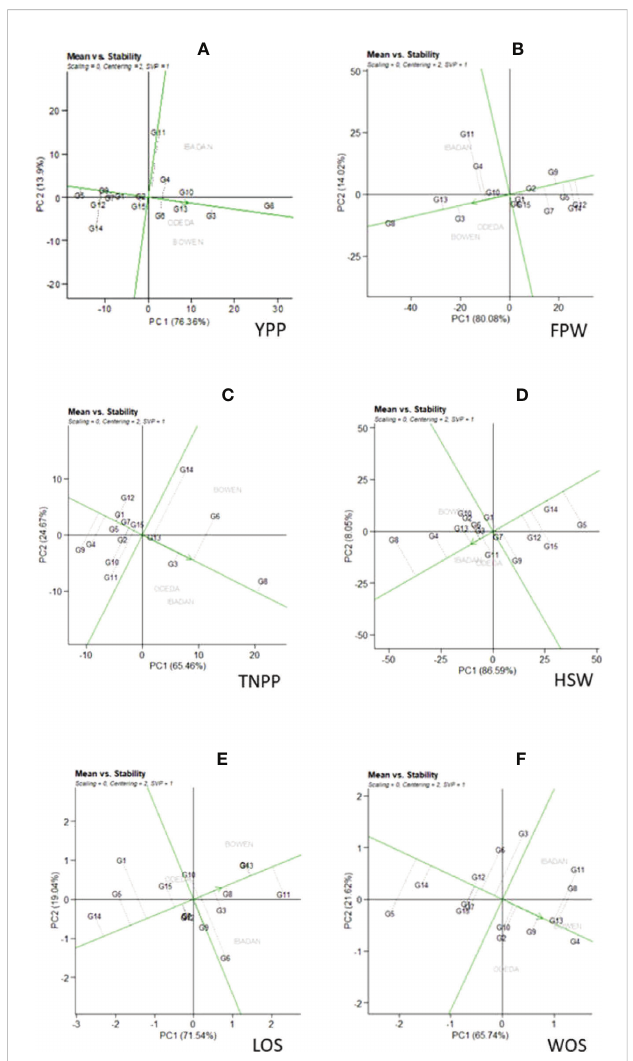
FIGURE 5 Patterns (A – F) . Mean vs. stability based on PC1 and PC2 showing G × E interactions of the 15 Bambara groundnut accessions under three sites: (A) yield per plant (YPP), (B) fresh pod weight (FPW), (C) total no. of pods per plant (TNPP), (D) hundred seed weight (HSW), (E) length of seeds (LOS), and (F) width of seeds (WOS). The mean vs. stability was based on scaling = 0, centering = 2, and singular value partitioning (SVP) =